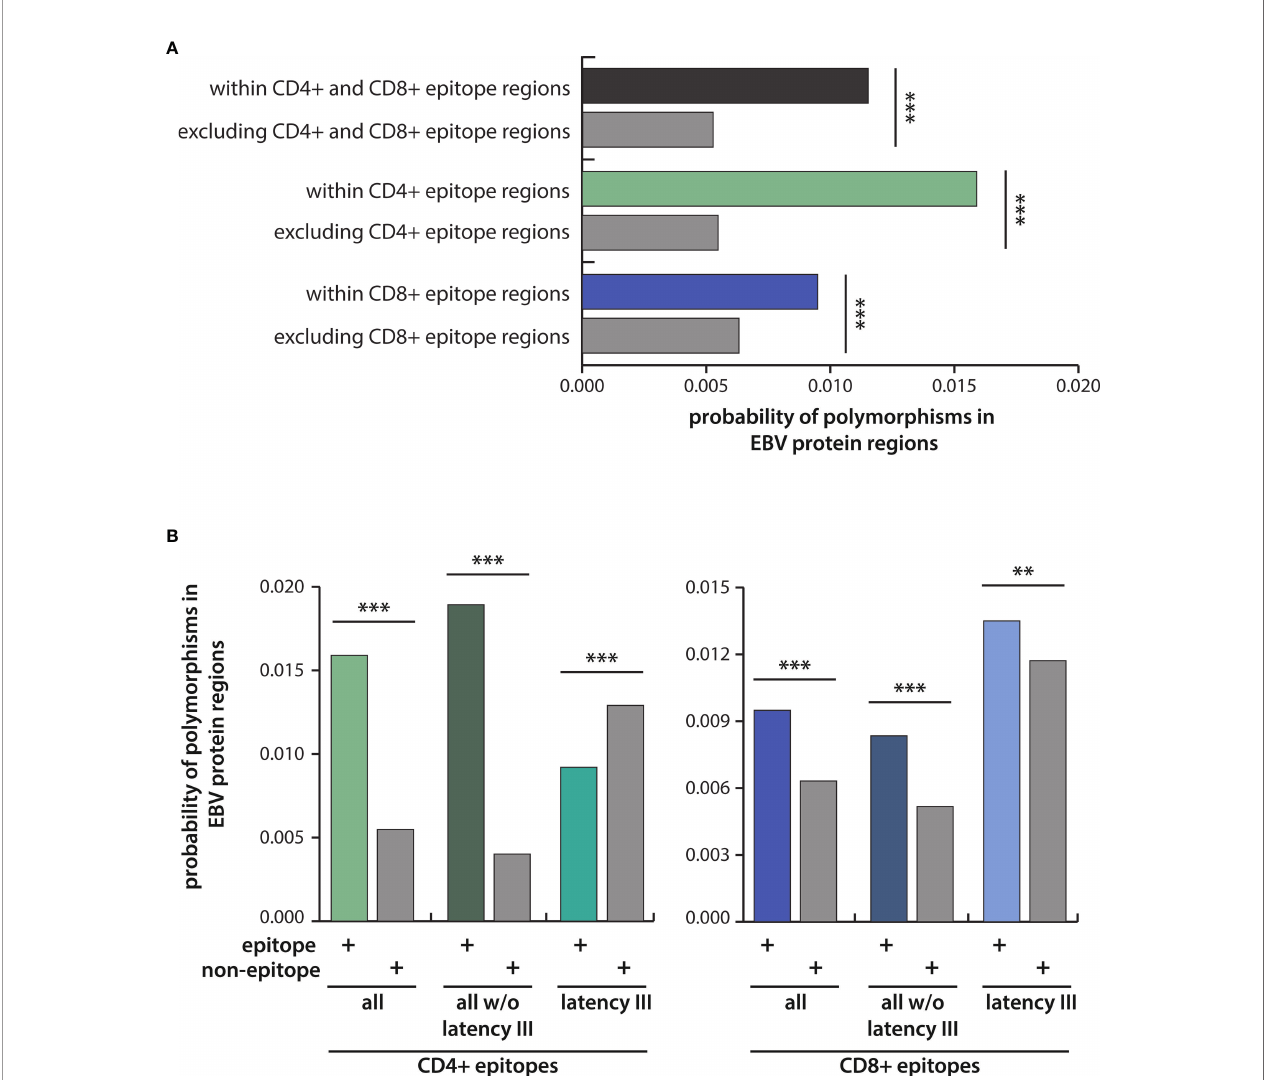
FIGURE 5 | Probabilities of polymorphisms occurring within epitope regions in comparison to the rest of the protein. (A) Depicted are the probabilities of amino acid exchanges occurring within T-cell epitopes in comparison to the rest of the protein for all CD4+ and CD8+ T-cell epitopes taken together, and for CD4+ and CD8+ T- cell epitopes separately. (B) Probabilities for polymorphisms in CD4+ (left) and CD8+ (right) T-cell epitopes were further analyzed for latency III antigens (EBNA2, EBNA- LP, EBNA3A, B, C) and for all antigens except latency III antigens. Statistical signi fi cance was tested with the Kolmogorov-Smirnov test, which was performed including each data point of the different EBV strains for all 32 EBV proteins using weight-adjusted probabilities (for details see Methods section). ** p < 0.05; *** p <